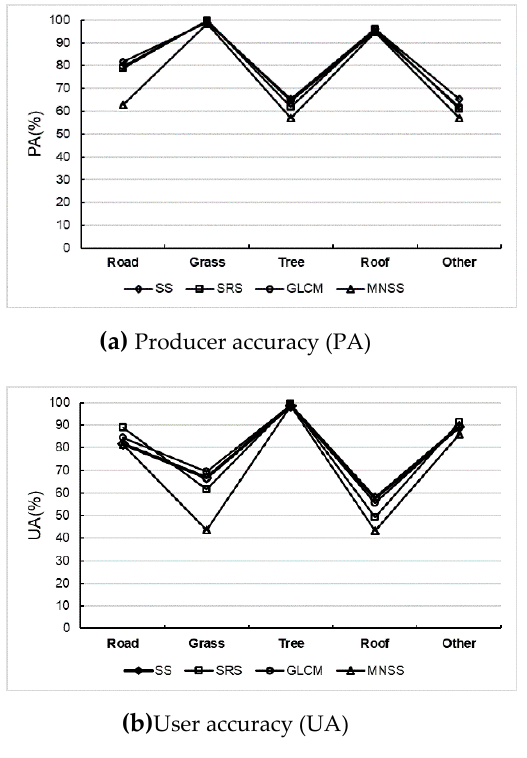
Figure 8. Accuracy assessment by different sampling methods.